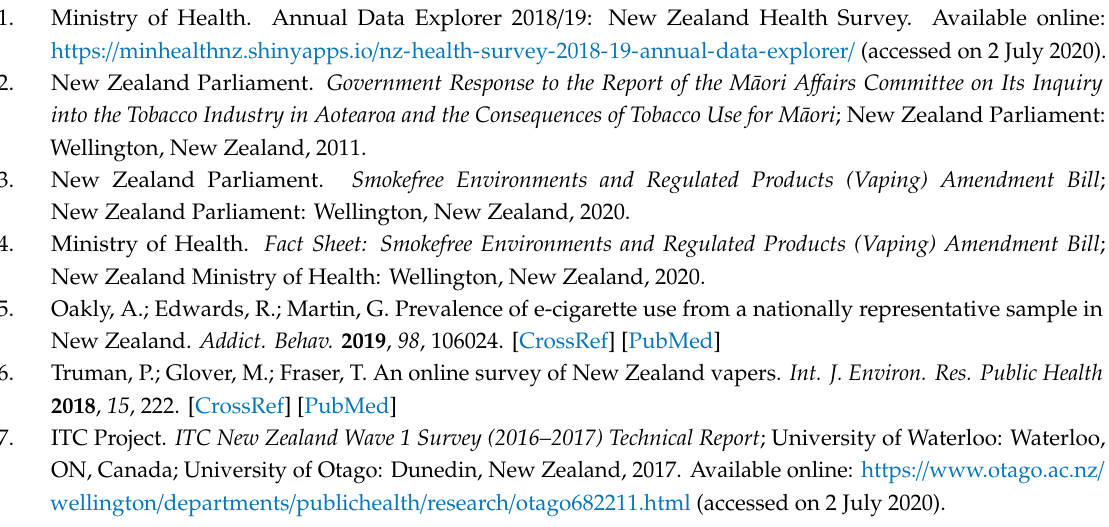
Table S1: E-cigarette related questions in the Wave 2 of the ITC NZ Survey; Table S2: Changes (absolute di ff erence, 95% CI) in awareness and use of vaping products from Wave 1 to Wave 2 (supplement to Table 2 in